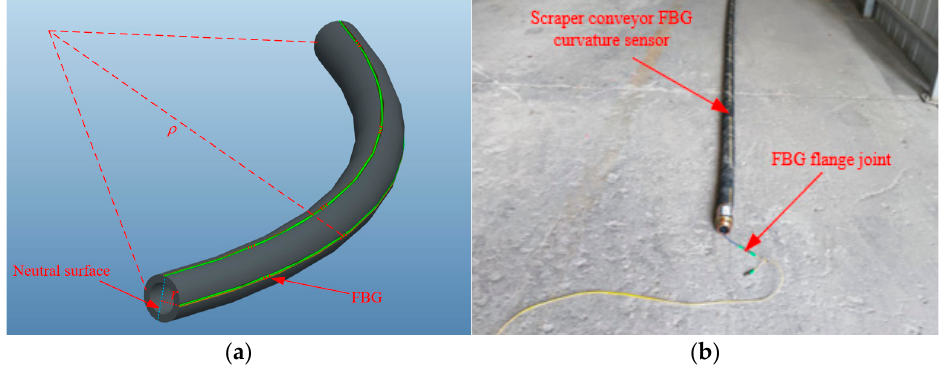
Figure 2. Schematic diagram and photo of FBG curvature sensor of scraper conveyor. ( a ) Schematic diagram; ( b ) photo.